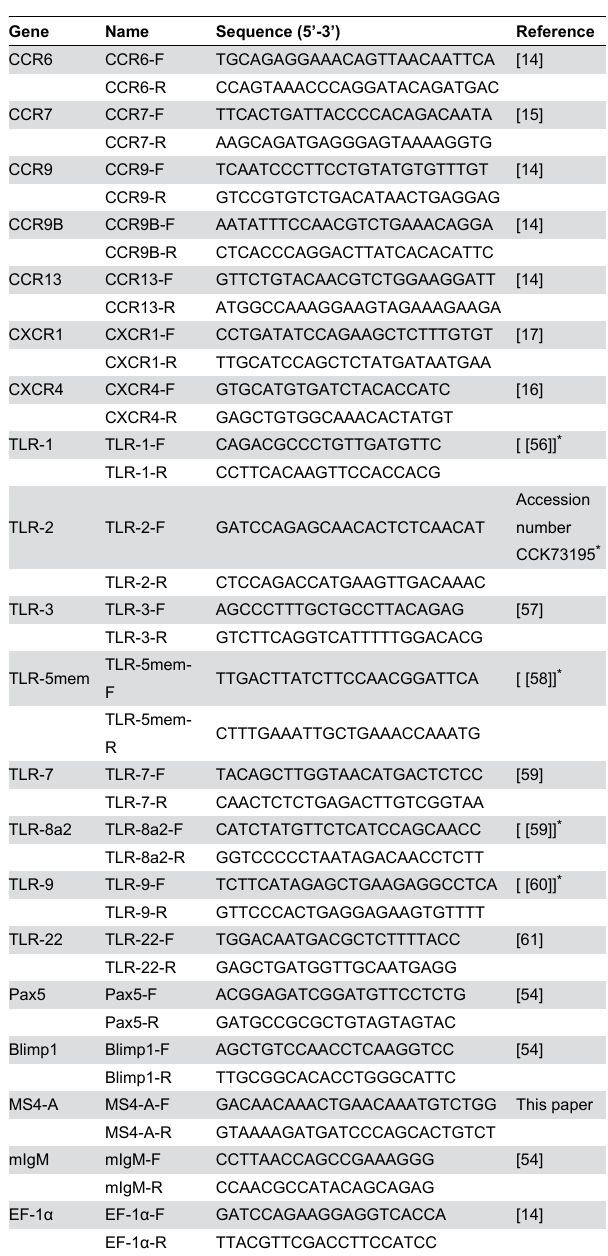
Table 1. Primers used in real time